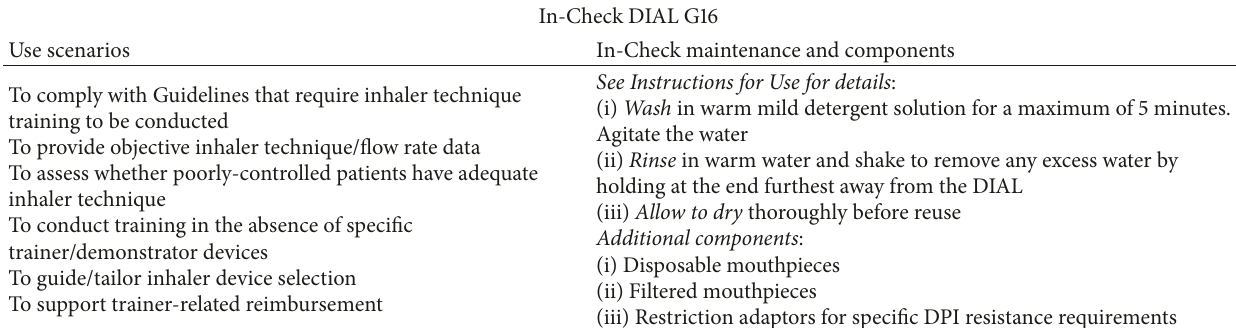
Table 3: Use scenarios and maintenance of the In-Check DIAL G16. In-Check DIAL G16